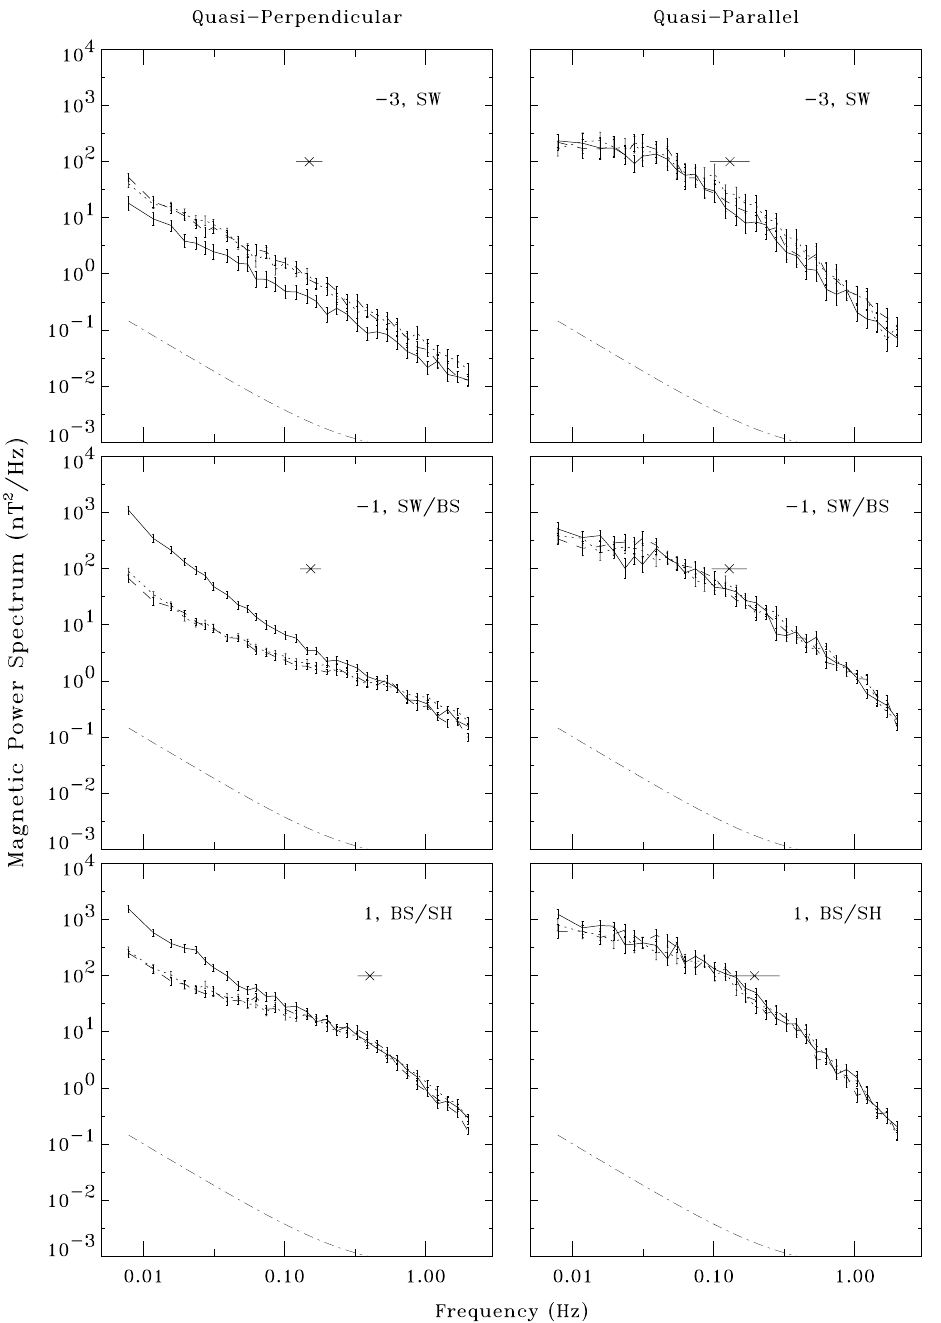
Fig. 2. Superposed-epoch analysis of magnetic spectra of 92 quasi-perpendicular (left) and 40 quasi-parallel bow shock crossings (right) from 3min upstream to 1 min downstream. Solid line is a compressive component; dashed line is a left hand polarized component; dotted line is a right hand polarized component. The cross with the horizontal error bar marks the proton cyclotron frequency. The acronyms SW, BS, SH mean solar wind, bow shock, and magnetosheath, respectively. Dash-dot line at the bottom of each figure is the instrumental noise